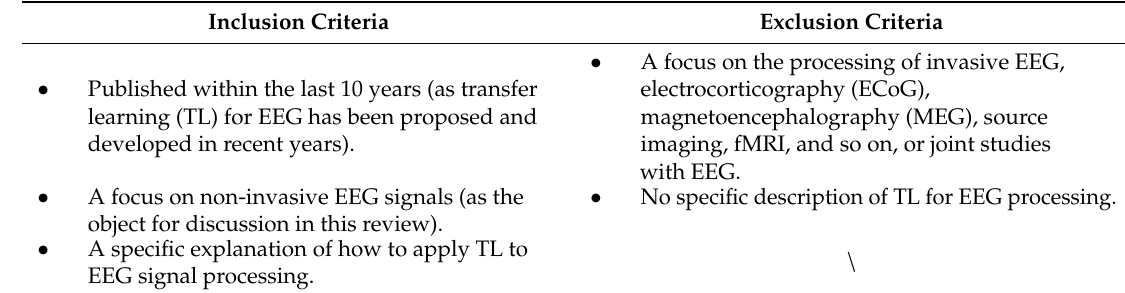
Table 1. Inclusion and exclusion criteria.